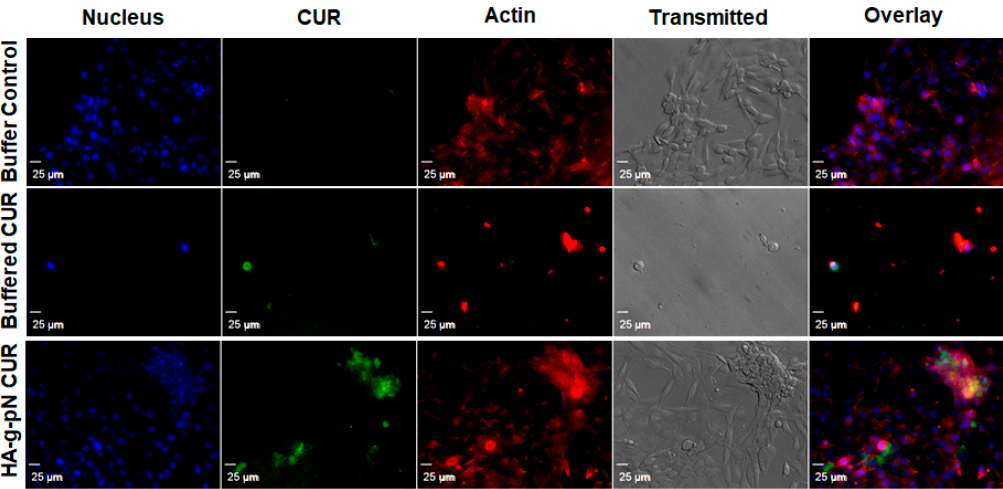
Figure 4. Confocal microscopy shows the cellular drug uptake in NIH-3T3 cells. DAPI (nuclear staining) and rhodamine- phalloidin (actin staining) were used as counter-stains. The images were obtained using Olympus IX81 with DSU confocal mode under a 20X oil lens (NA = 0.85). Exposure times were kept constant for all samples (500 ms for DAPI and rhodamine- phalloidin, 1000 ms for curcumin).